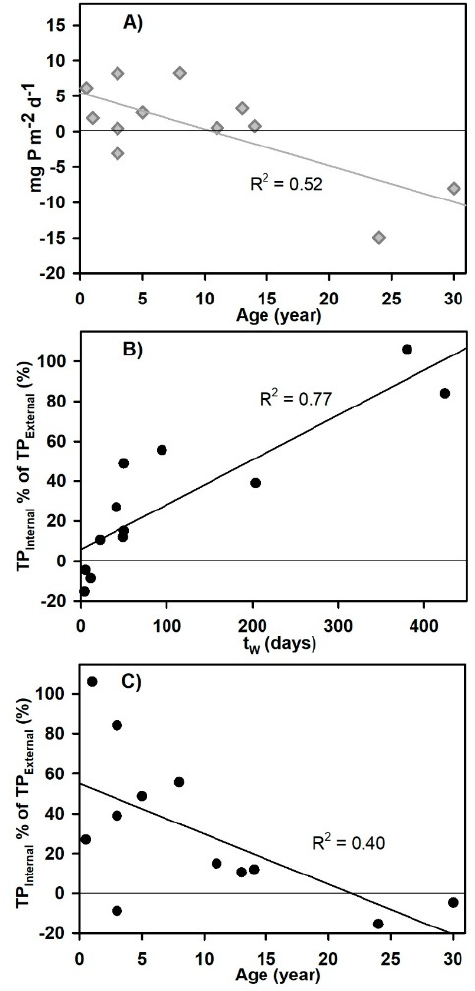
Figure 5. ( A ) Regression between the internal loading estimated from the TP-concentration changes during summer (TP Internal ) and the age of the new lakes at the time of sampling. ( B ) Regression between the hydrological residence time (t W ) of the lakes and the importance of the internal P-loading as a source of P expressed as the proportion of TP Internal to TP External by the method providing the closest estimation of modeled annual average TP-concentration (TP ModAnnual ) of each lake. ( C ) Regression between the contributions of TP Internal in relation to TP External to the age of the new lakes.